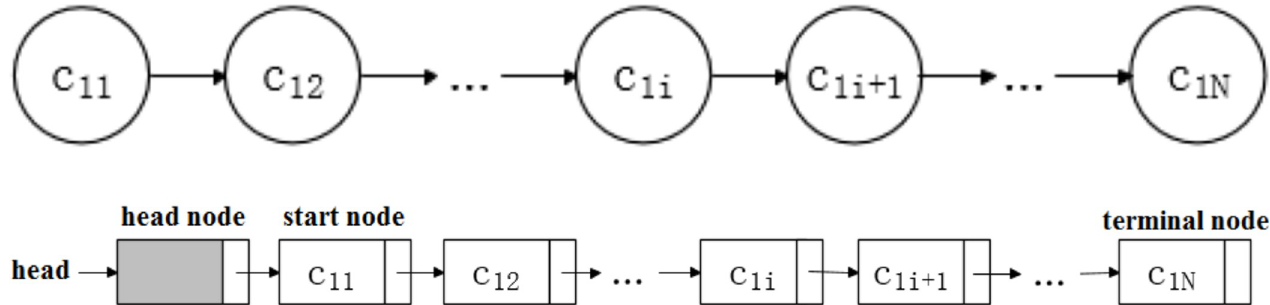
Fig 10. Structure of single seed root. (a) Logical structure; (b) Storage structure.